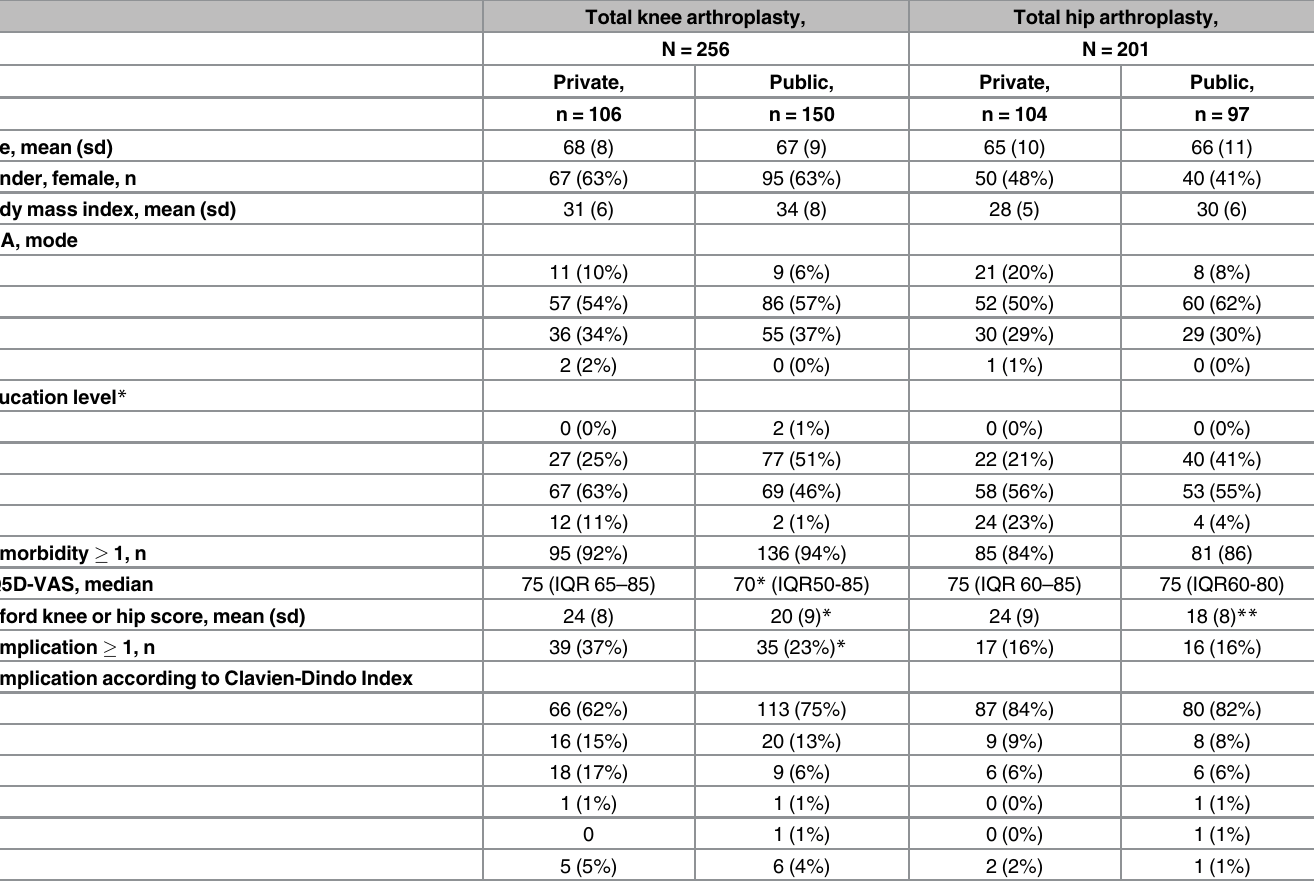
Table 2. Characteristics of the analysed cohort by arthroplasty type and sector.